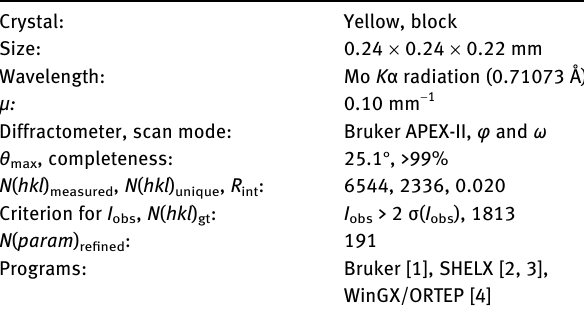
Table  : Data collection and